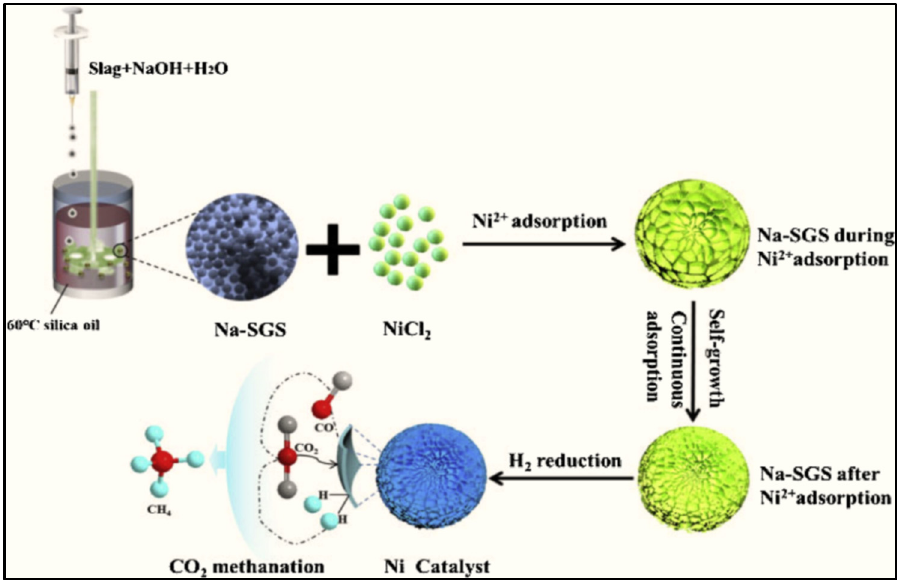
Figure 4. Schematic diagram of the preparation Na-SGS, absorption and then reduction to be a catalyst for the CO 2 hydromethanation [182].